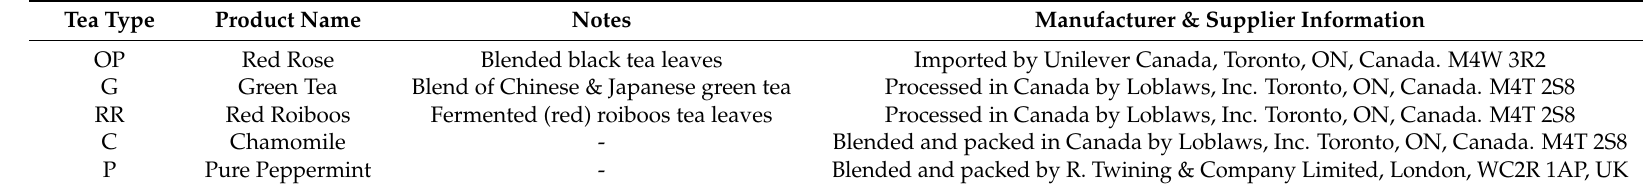
Table A3. Tea product